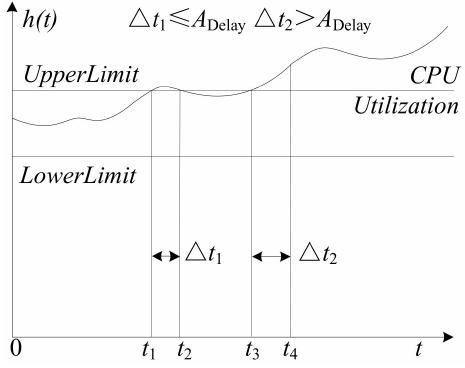
Figure 5. Analysis of Triggering-Delay Time A Delay